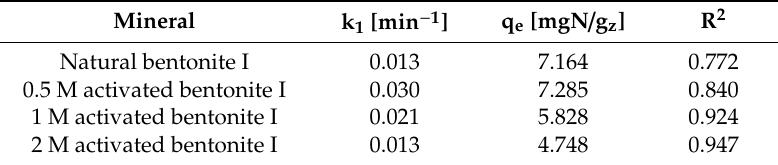
Table 2. The kinetic parameters for ammonium ion exchange using the Freundlich model (0.5 M, 1 M, and 2 M indicate NaCl concentrations of 0.5, 1.0, and 2.0 mol / L